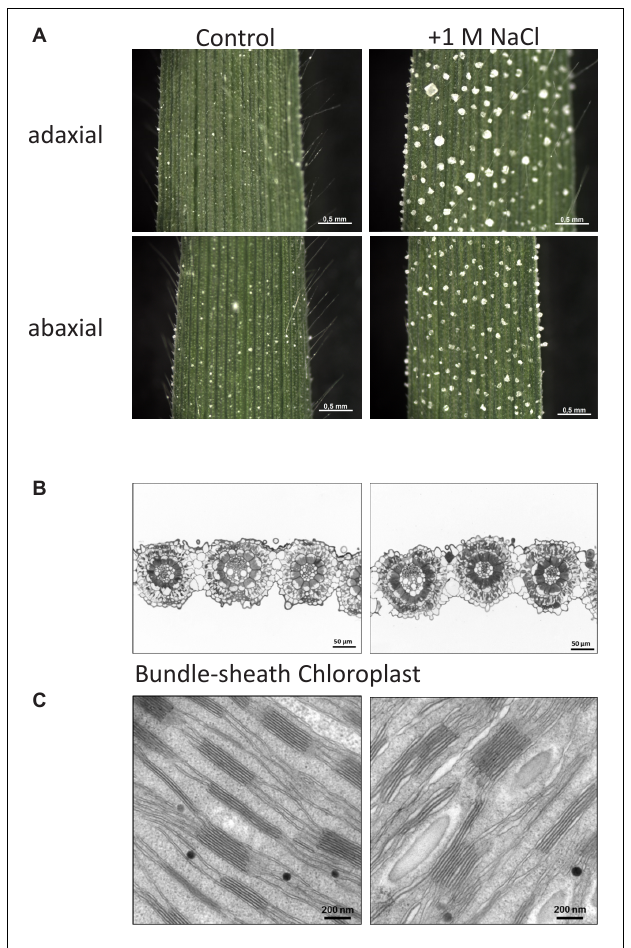
FIGURE 2 | (A) Leaf surface of young leaved developed in pots under greenhouse conditions at different watering regimes. Left: control (tap water) and right: salt watering (1 M NaCl). Shown are adaxial and abaxial sides of the leaves including formed salt crystals at salt watering condition. (B) Microscopic section of leaves after methylblue/azur II stain showing Kranz anatomy, typical indication for C4 type plant. Bundle sheath cells appear darker at salt treatment. (C) SEM analysis of thylakoid structure in bundle sheath cell chloroplasts. Grana staples are larger and show spaces between layers at salt